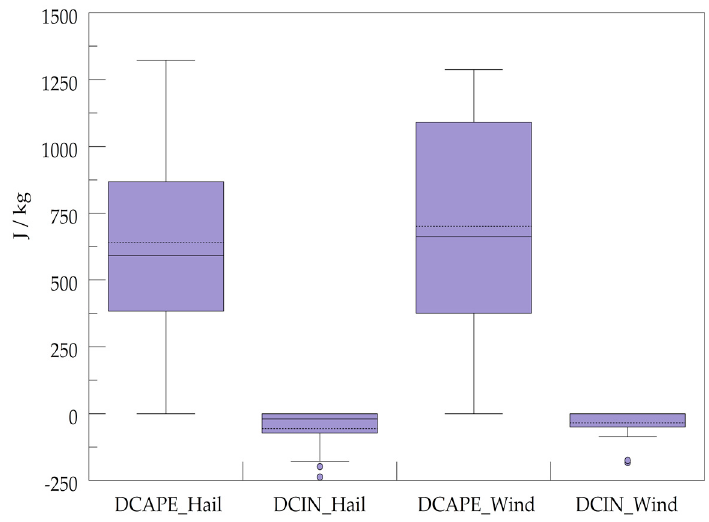
Figure 2. As in Figure 1, but comparing the Hail-Dominant case set on the left (ending in “_Hail”) to the Wind-Dominant case group on the right (ending in “_Wind”).